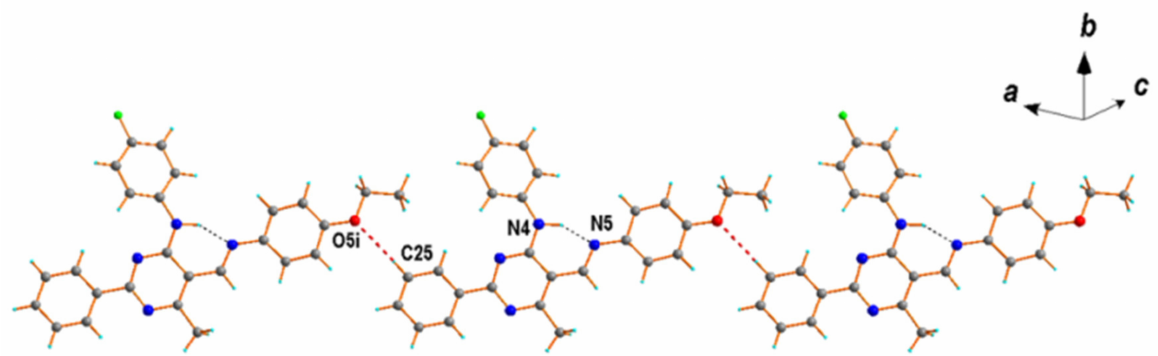
Figure 5. Part of the crystal structure of 3 showing the formation of the one-dimensional chain through C–H · · · O (in red) intermolecular interactions. The dashed lines (in black) indicate intramolecular N–H · · · N hydrogen bonds. Symmetry code is the same as in Table 1.